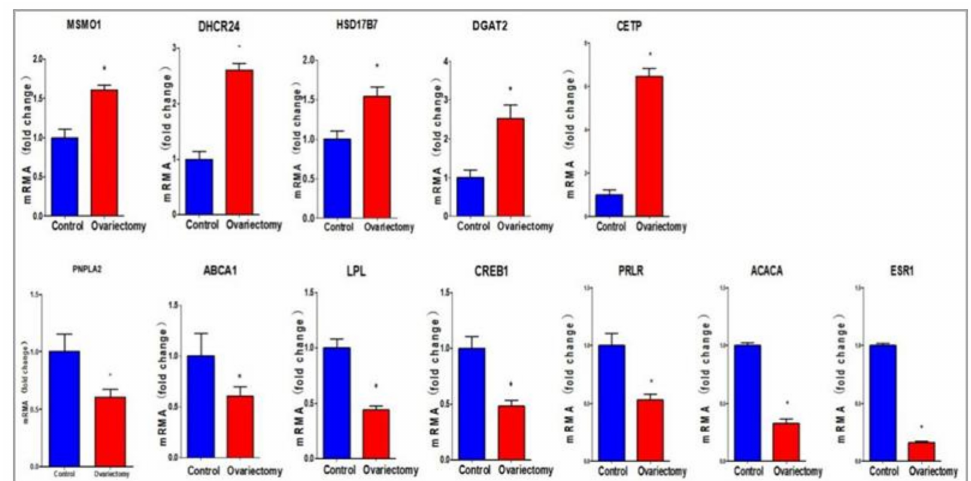
Figure 3. Real-time quantitative polymerase chain reaction (qRT-PCR) verification of DEGs detected by gene expression profiling. The expression levels of DEGs related to lipid metabolism determined by qRT-PCR in the ovariectomized and sham-operated groups. These genes were involved in glycerolipid metabolism, sterol biosynthesis, and fatty acid biosynthesis, among others. Each of these DEGs were up-regulated or down-regulated significantly ( p < 0.05) in the ovariectomized group compared with the sham-operated